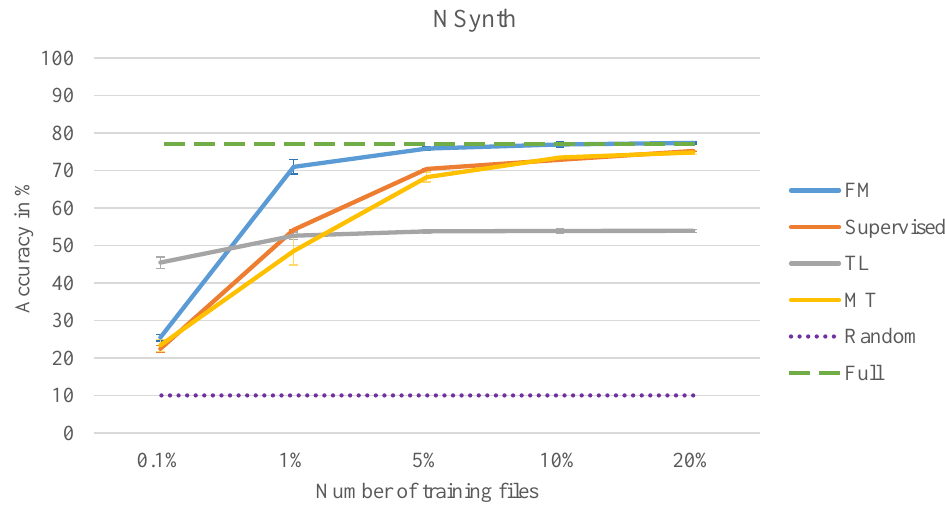
Figure 6. Mean accuracy and standard deviation for FixMatch (FM), fully supervised training (Supervised), Transfer Learning (TL), and Mean Teacher (MT) on NSynth test set. Additionally, the supervised baseline using the full training set (Full) and the random baseline are